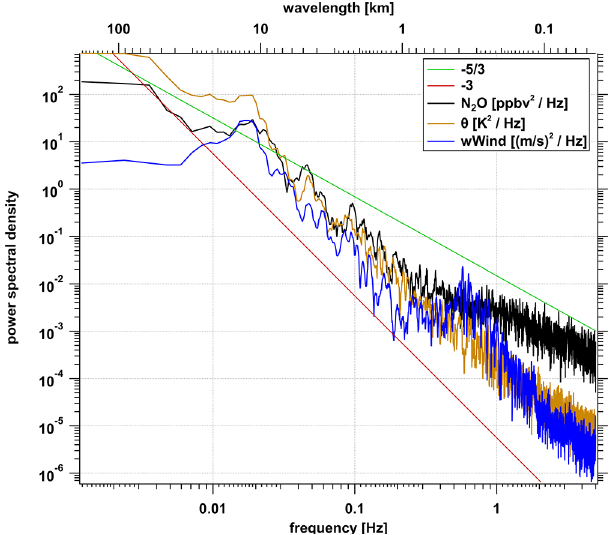
Figure 13. Power spectral density of vertical wind (blue), potential temperature (orange) and N 2 O (black) for the flight segment above the mountains. The power spectral density has been smoothed by a boxcar average of 5s. The green and red reference lines have slopes of − 5 / 3 and −